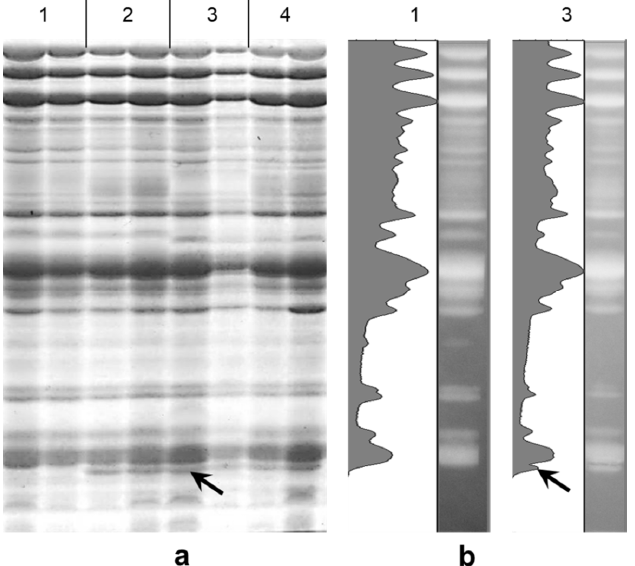
Figure 1. Electrophoregram of polyacrylamide gel ( a ) and densitograms ( b ) of soybean seed storage proteins. Germplasms are labelled above the image as follows: 1, Hilario; 2, Atlantic; 3, Triumph; and 4, Luna. The band for the 21 kDa molecular component KTI is indicated by arrows. Molecular analysis of Ti3 locus encoding KTI was carried out with three SSR markers. The markers Satt228 , Satt409 , and the gene-specific marker Ti/ti are tightly linked to the Ti3 locus, and they can be perfectly used as diagnostic markers for MAS of genotypes with the null-allele ti3 . Amplification products of these markers during PCR analysis with DNA from two soybean cultivars with low KTI (Hilario and Ascasubi) and one local cultivar Lastochka with high KTI are shown in Figure 2. The presented data confirmed that both Italian cultivars (Hilario and Ascasubi) have null-allele ti3 while Kazakh cultivar has dominant allele Ti3 in the locus.